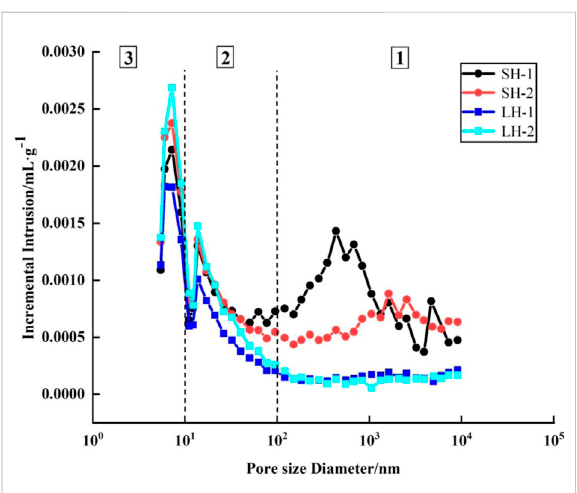
FIGURE 3 Relationship between stage mercury injection and pore